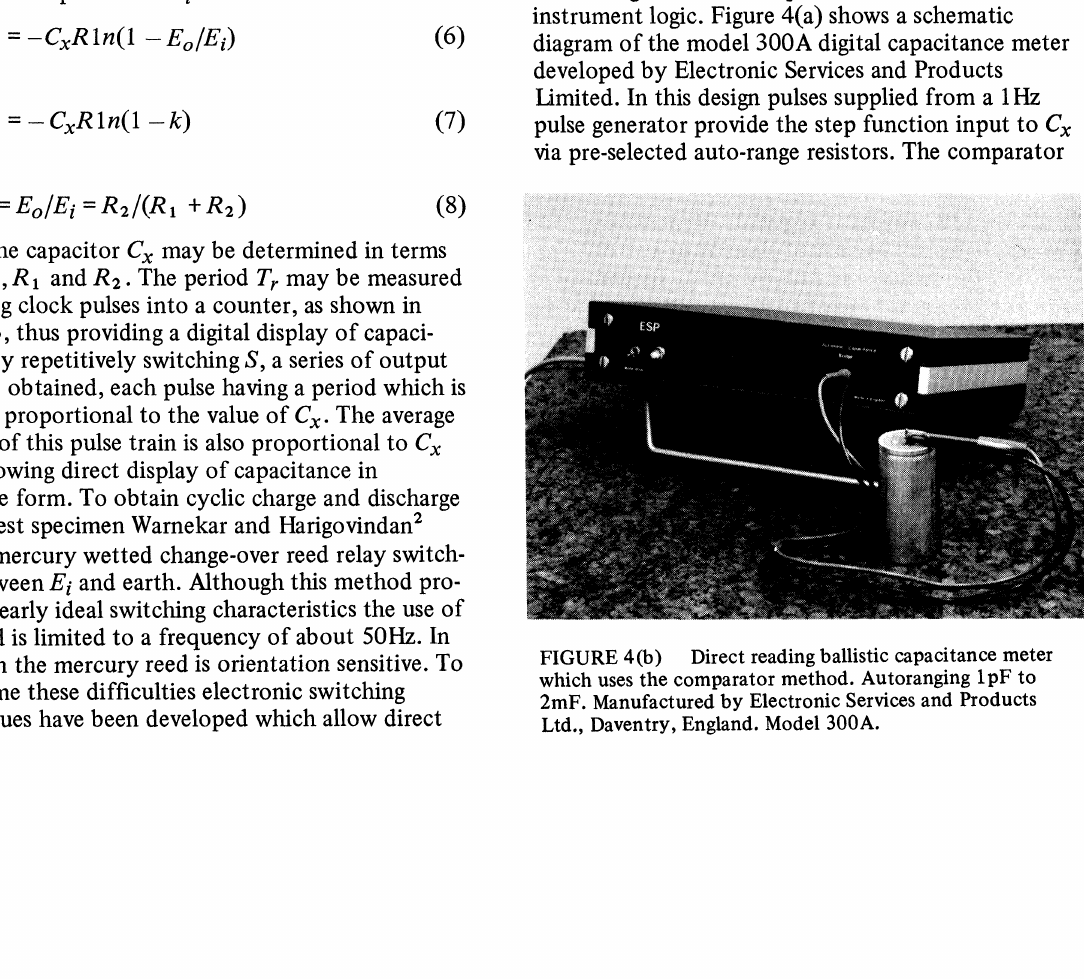
Schematic diagram of an autoranging ballistic capacitance meter which employs electronic switching to charge and discharge C